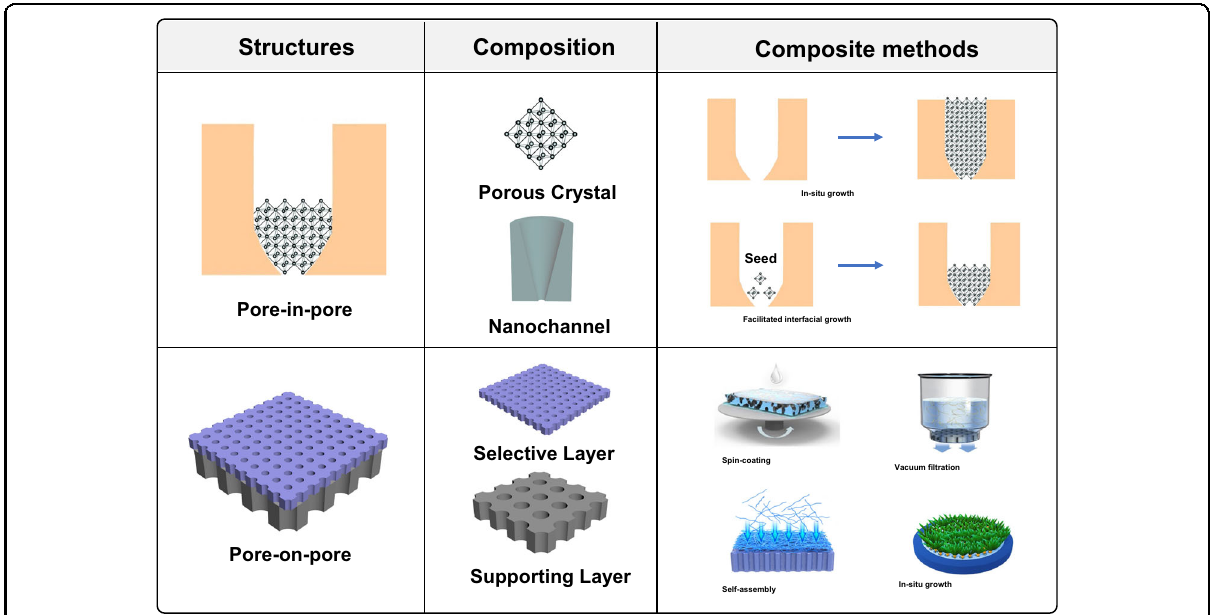
Fig. 2 Design rationale of hierarchical nanochannel systems. Typical hierarchical nanochannel systems showing a pore-in-pore or pore-on-pore structure constructed from different materials. Typical building methods include in situ growth and seeding-facilitated interfacial growth for the pore- in-pore structure and spin-coating (Reproduced with permission 26 . CC BY 4.0 (https://creativecommons.org/licenses/by-nc/4.0/)), vacuum fi ltration (Reproduced with permission 29 . CC BY (https://creativecommons.org/licenses/)), self-assembly (Reproduced with permission 32 . Copyright 2022, American Chemical Society.), in situ growth (Reproduced with permission 34 . Copyright 2019, Wiley-VCH.) for the pore-on-pore